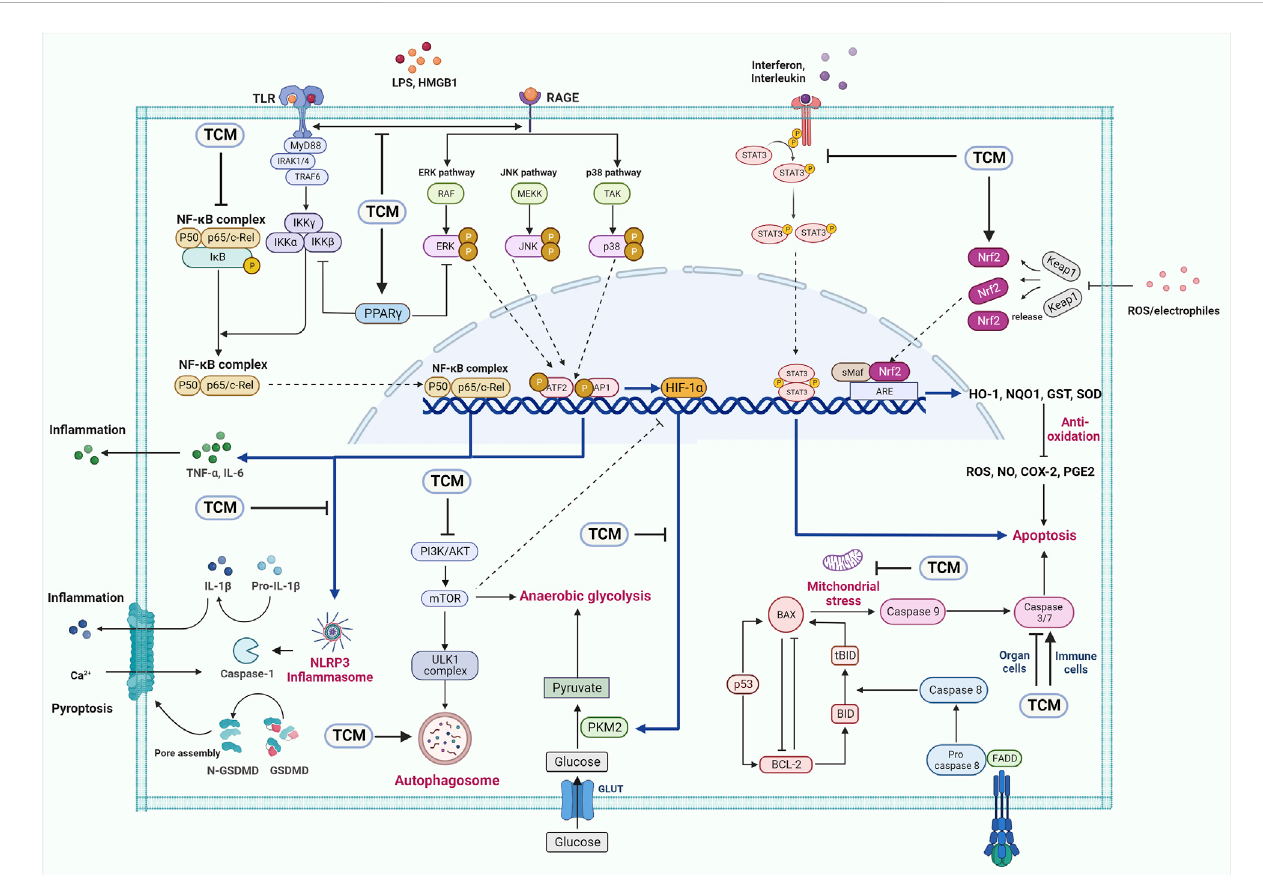
Thepotential applications ofTCMinsepsis. TCMcanprotectsepsis throughTLR4/NF- κ B, PI3K/mTOR, NLRP3in fl ammasome, MAPK andothersignaling